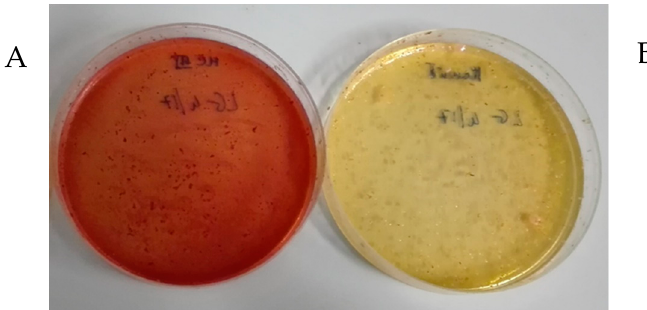
Figure 6. Lisosan ® G (LG 1 ) was tested for presence of coliforms and staphylococci in ( A ) McConkey III agar medium and ( B ) mannitol salt agar medium, respectively. A total of 500 mg of Lisosan ® G was plated. No Colony Forming Unit (CFU) were observed. In ( B ) the medium turned pink to yellow due to the low pH of the fermented product.